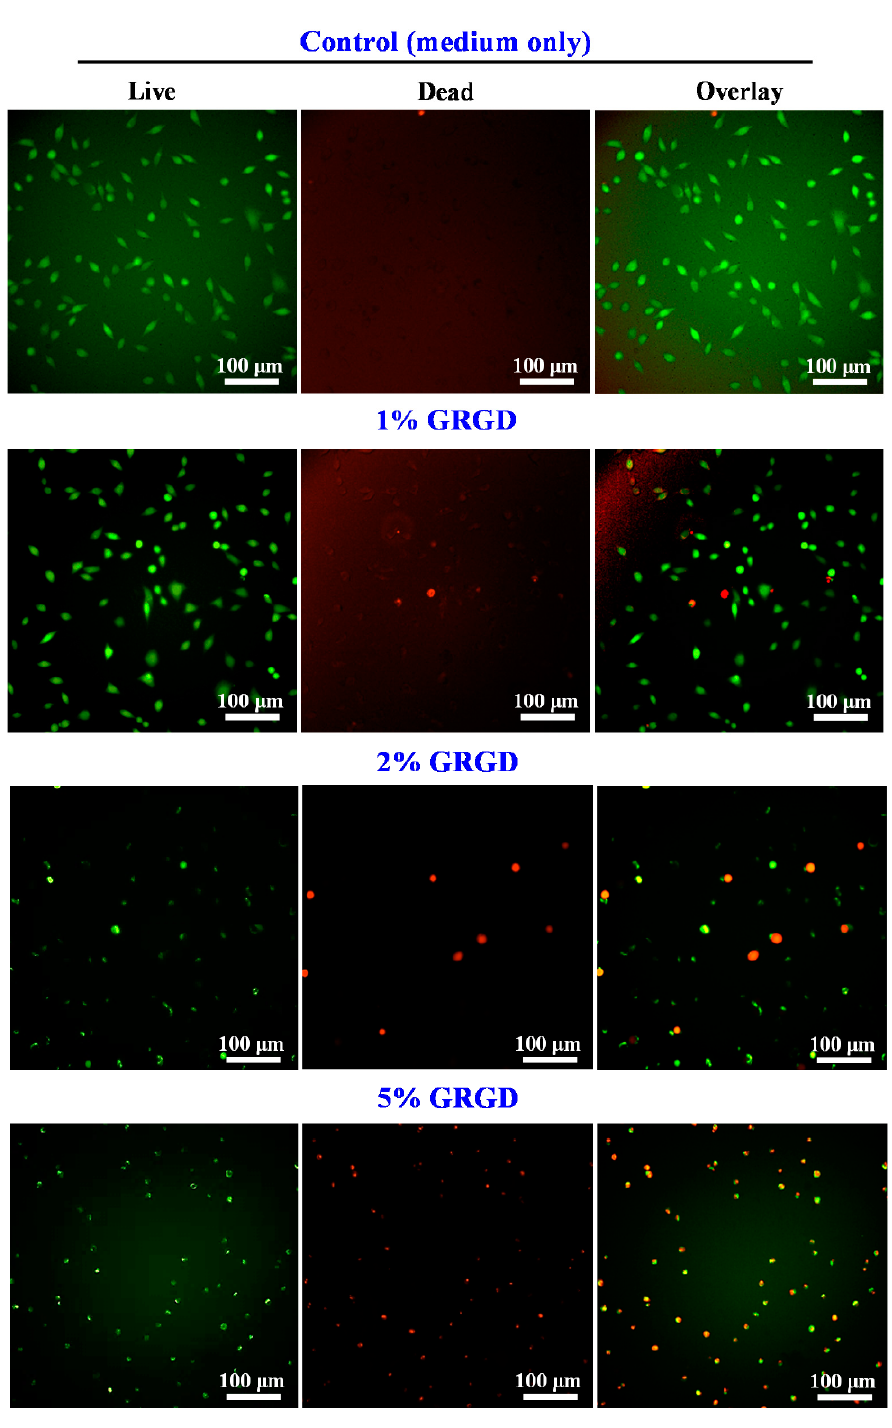
Figure 4. The result of the live/dead cell assay after the L929 cells were cultured in different concentrations of the GRGD peptide for 24 h. Magnification = 10 ×